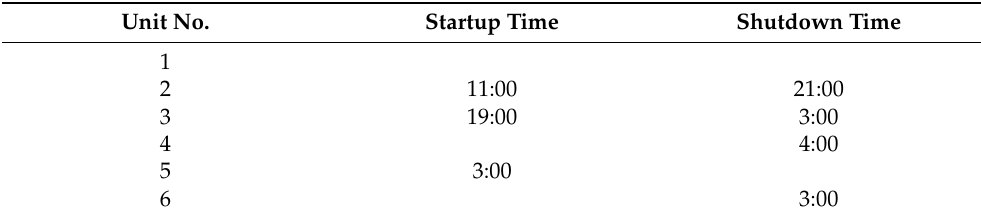
Table 4. The unit start/stop status within the simulation period with DR participation.